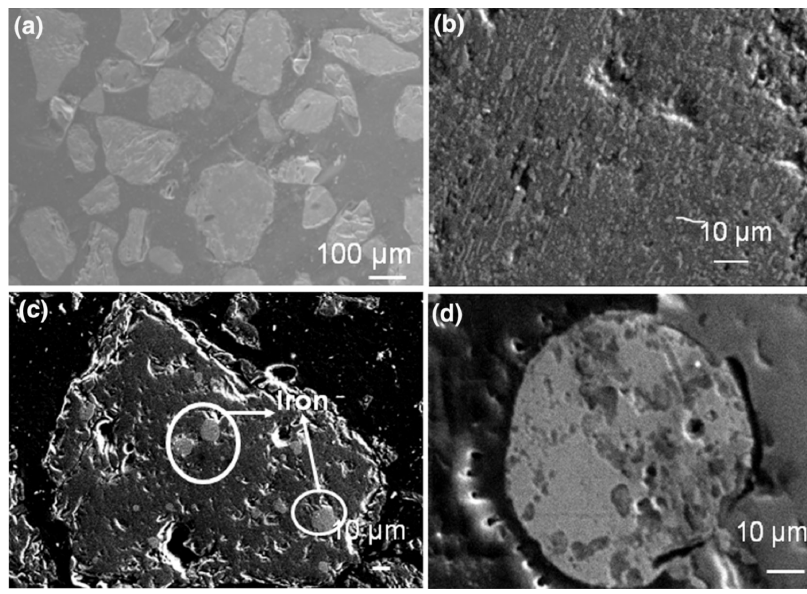
Figure 14. Scanning electron microscope images of: ( a ) cross-section view of ilmenite grains; ( b ) enlarged view of metallized ilmenite; ( c ) plasma product slag; ( d ) bulk iron. Reprinted from [51] with permission from Springer 2016.